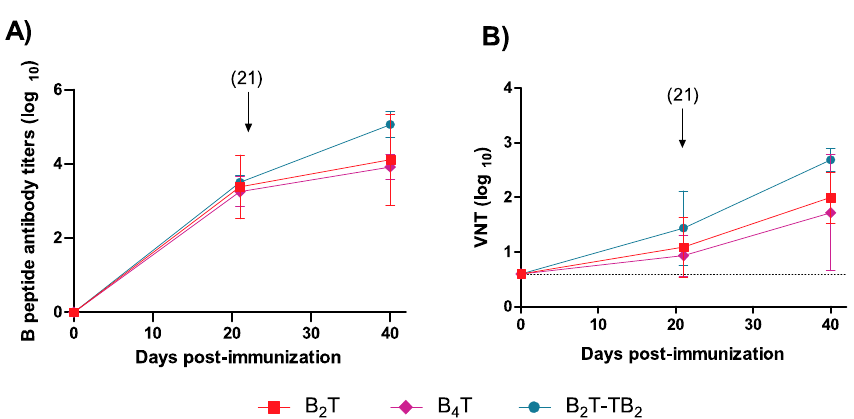
Figure 2. Anti-FMDV antibody responses of mice vaccinated with conjugates B 2 T(mal), B 4 T(thi), and B 2 T-TB 2 (click). ( A ) ELISA-determined anti-B peptide response in sera collected at the indicated days post-immunization. Each point depicts mean antibody titers ± SD for each group. Arrow shows the day of boost. ( B ) Neutralizing (VNT) antibody responses at days 21 (pre-boost) and 40 (post-boost) pi. Dotted line indicates the detection limit. Each symbol represents the value for an individual mouse. Horizontal lines indicate the geometric mean for each animal group. No individual spontaneous reactivity was observed in the titers determined at day 0. Differences were not statistically significant.